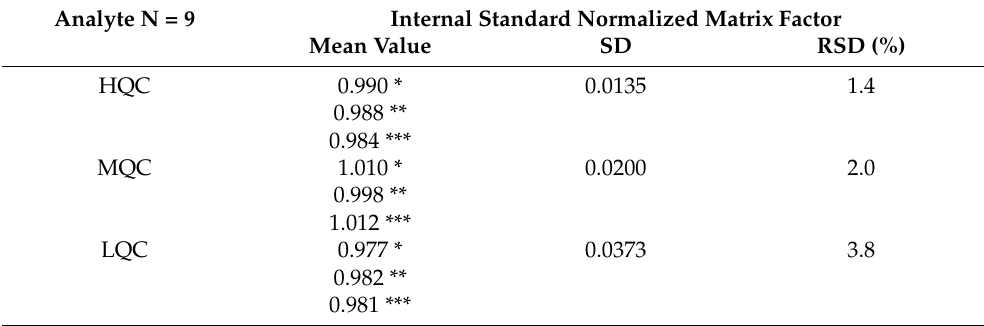
Table 1. The matrix effect results of the different